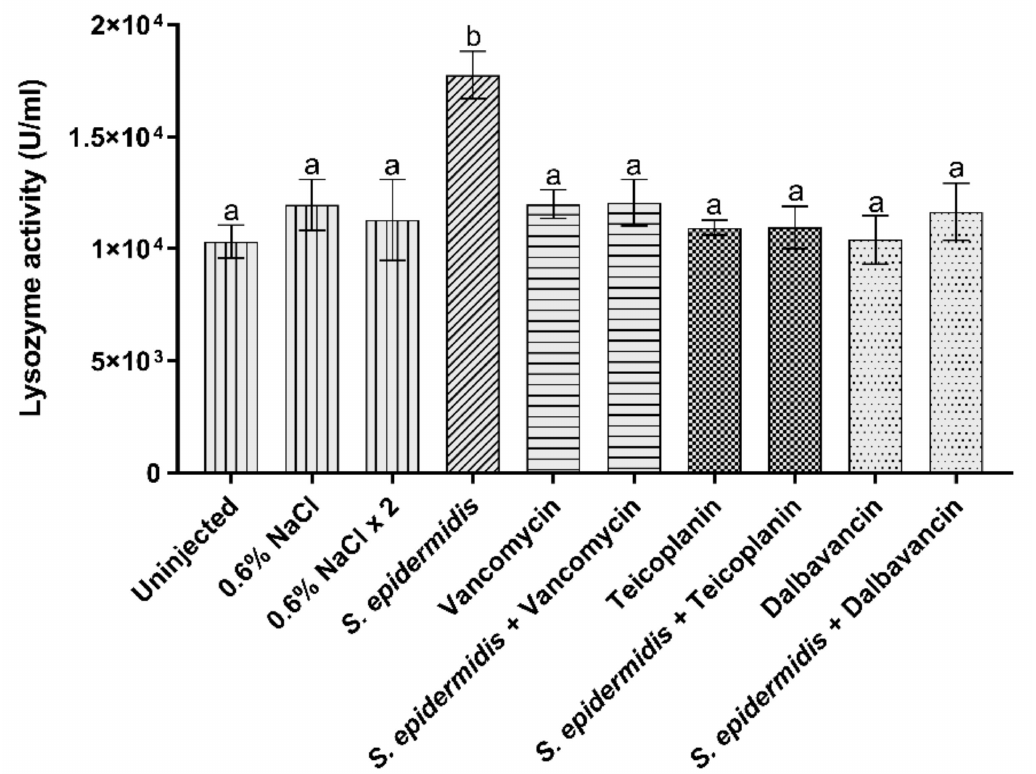
Figure 5. Lysozyme relative activity. Values represent mean ± s.e.m. Different letters indicate statistically significant differences among treatments ( p <